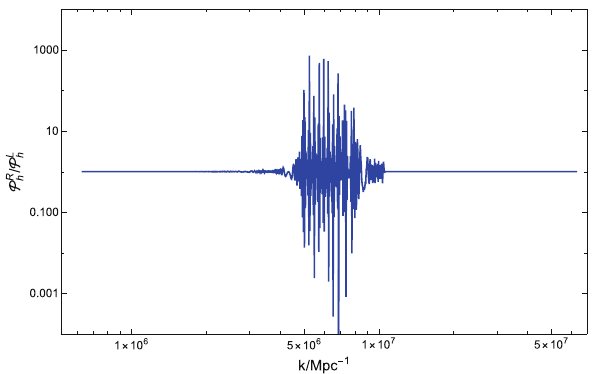
to P L for case 1 h h